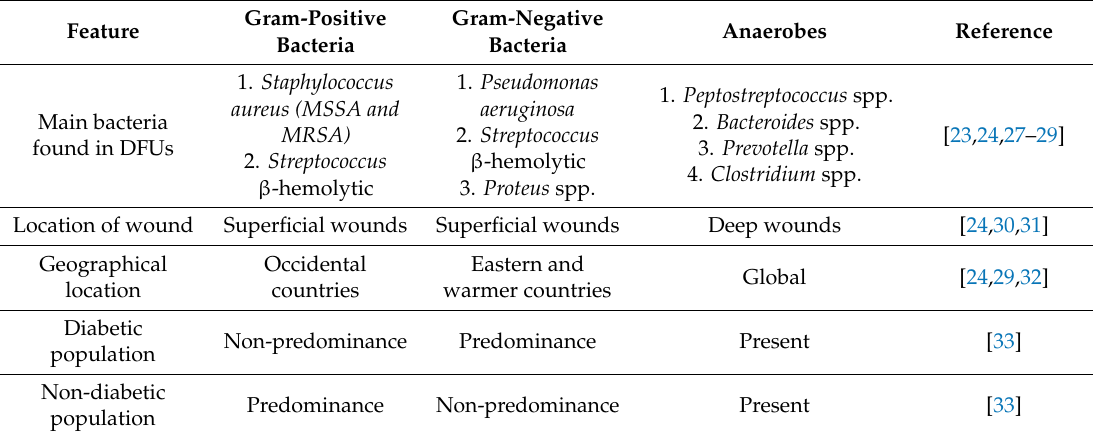
Table 2. Microbiota in diabetic foot ulcers (DFUs). MSSA—methicillin-susceptible Staphylococcus aureus